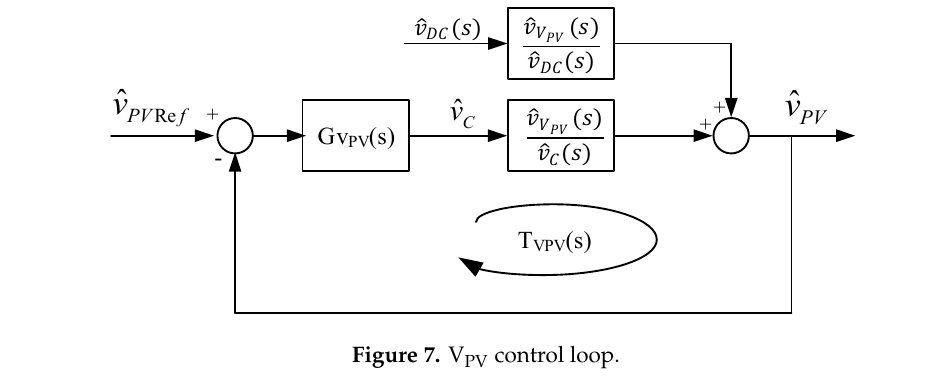
/ˆv C ( s ) response and ( b ) open loop PV